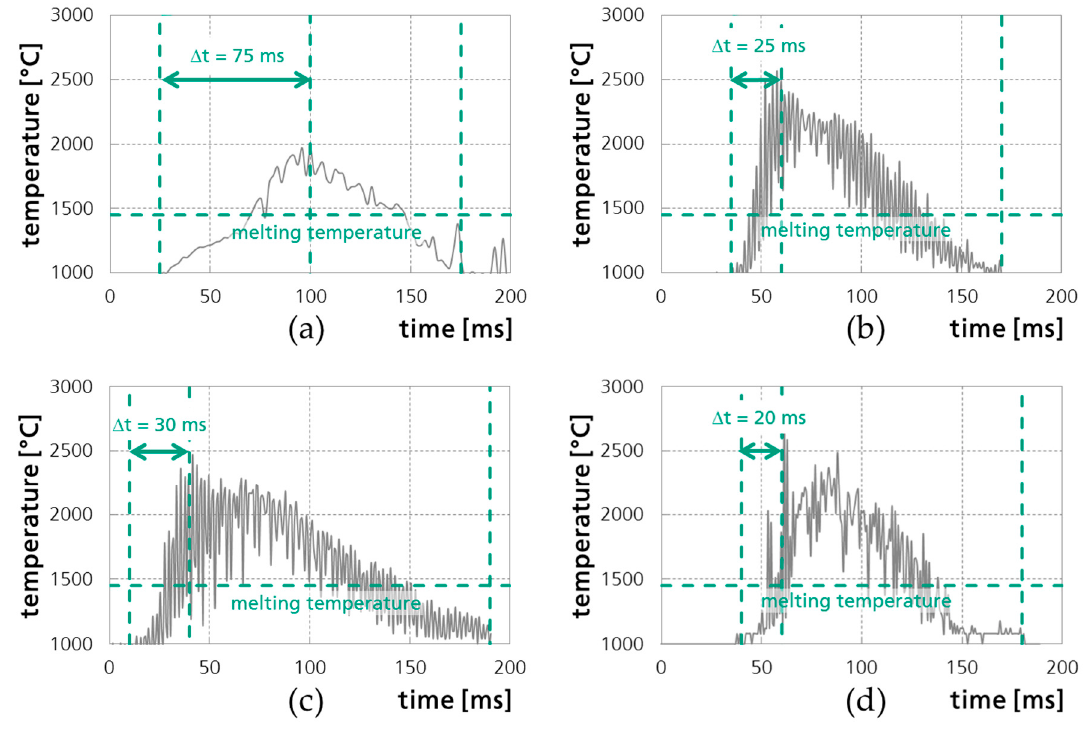
Figure 21. Comparison of the local temperature for the submatrix T (cid:48) p ( t ) ,p ( t ) calculated with e = 1 showing one certain material position of 12 mm stainless steel along the cut path as function of time for the following: ( a ) Static beam shaping; and different values of the longitudinal, linear beam oscillation parameters: ( b ) 300 µm amplitude and 500 Hz frequency; ( c ) 550 µm amplitude and 500 Hz frequency; ( d ) 300 µm amplitude and 2000 Hz frequency.